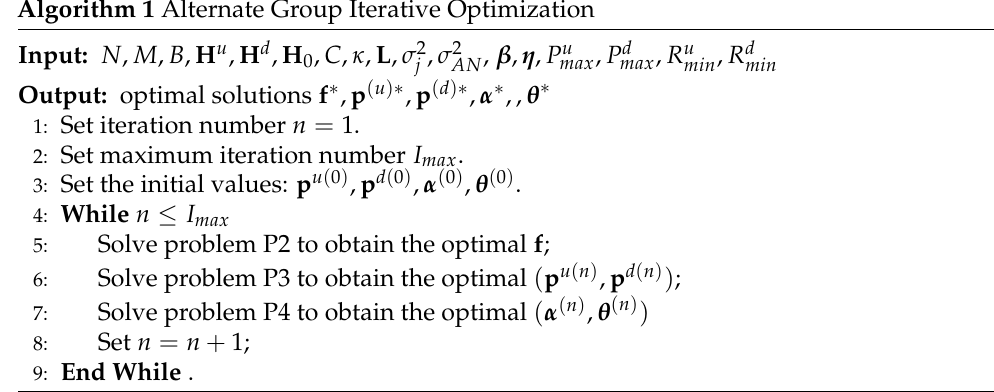
Algorithm 1 Alternate Group Iterative